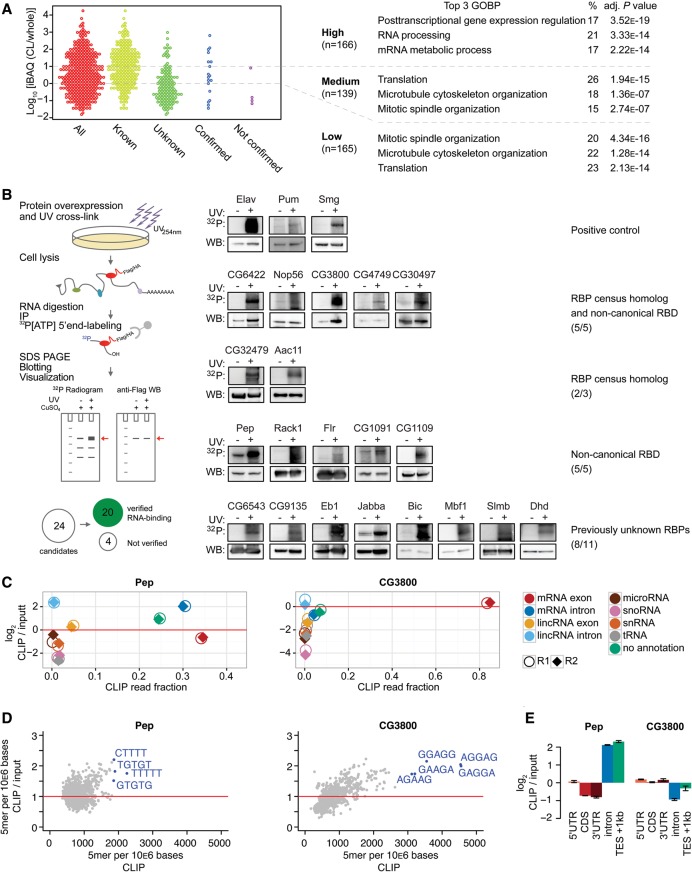
Validation of direct RNA interaction of candidate RBPs. (A) Protein enrichment (log10 iBAQ ratios of proteins in oligo[dT] precipitate versus whole-embryo proteins). Proteins are divided by enrichment score (high = >10-fold enrichment, middle = 1–10-fold enrichment, low = <1-fold enrichment) (six proteins [two validation candidates] missed whole embryo detection and could not be added here). The three most enriched GO-terms for biological processes (GOBP) for each category are shown on the right. Validation candidates were chosen throughout the enrichment ratio range, and were not annotated as RNA-binding in GOMF or having classical RBDs (except Pep). (B) Scheme describing the experimental approach. Epitope-tagged candidate RBPs were expressed in transiently or stably transfected Drosophila S2 cells. After 254-nm UV-crosslinking, cell lysis, and RNase digestion, the immunoprecipitated crosslinked protein-RNA complexes were radiolabeled by T4 PNK phosphorylation and separated by SDS-PAGE. 32P-autoradiogram and Western blot analysis of 254-nm UV-crosslinked (+) and noncrosslinked (−) complexes for each indicated RBP candidate are shown. Known RBPs (Elav, Pum, Smg), served as positive controls. RNA-signals were compared against FLAG-IP of crosslinked parental S2 cells to estimate nonspecific signal. RBP candidates Wech, GlyP, Hsc70Cb, and CG6287 could not be verified. (C) Enrichment of uniquely aligned CLIP sequencing reads relative to matched total RNA input for Pep and CG3800. X-axis: fraction of reads per million (RPM). Y-axis: log2-transformed RPM ratio of CLIP vs input samples. (Circles, replicate 1; diamonds, replicate 2.) (D) 5-mer enrichment of randomly sampled aligned RBP CLIP reads relative to matched inputs. X-axis: frequency of 5-mer in 106 bases. Y-axis: 5-mer frequency ratio CLIP vs. input. (E) Enrichment analysis of aligned sequencing reads to mRNA subannotation categories. Sequencing reads were normalized to reads per kilo base per million (RPKM). Y-axis: log2-transformed ratio of annotation categories RPKMs in CLIP vs. input. (TES) transcription end site.